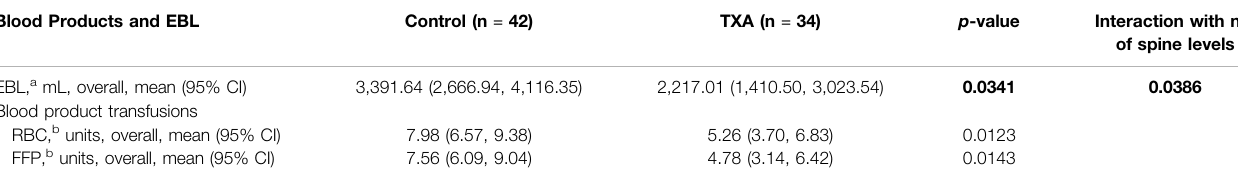
TABLE 3 | Estimated blood loss and amount of intraoperative blood transfusion from multivariate models. Blood Products and EBL